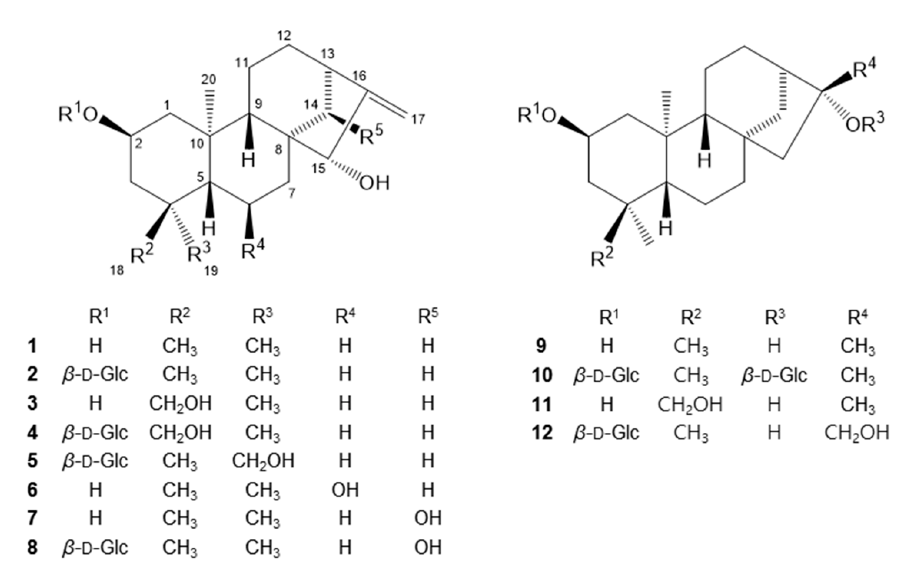
Figure 1. Chemical structures of the isolated compounds 1 – 12 from P. multifida.